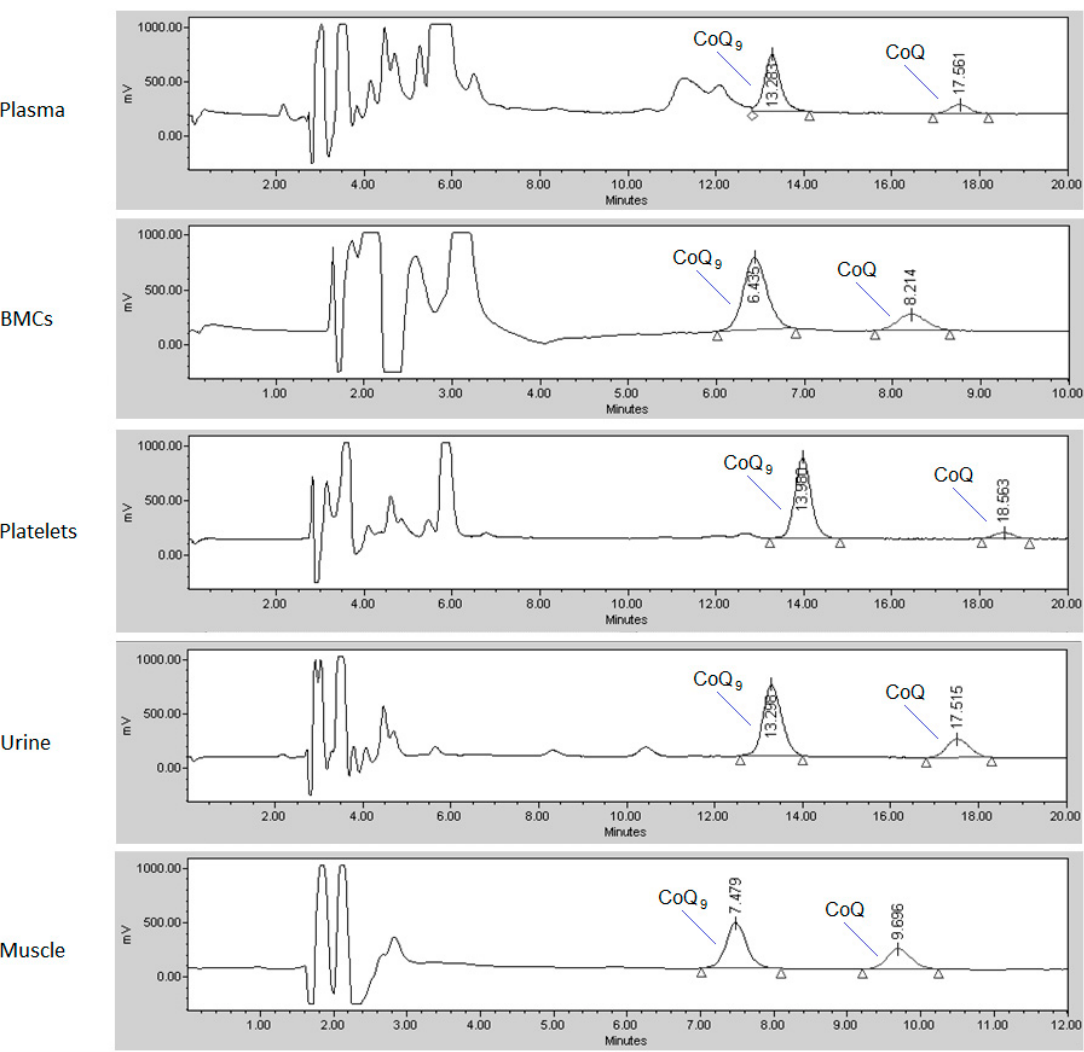
Figure 1. Typical chromatograms of coenzyme Q 10 (CoQ) determination (HPLC with electrochemical detection) in the different biological samples: plasma, platelets, blood mononuclear cells (BMCs), urine, and muscle. Coenzyme Q 9 (CoQ 9 ) was used as the internal standard.